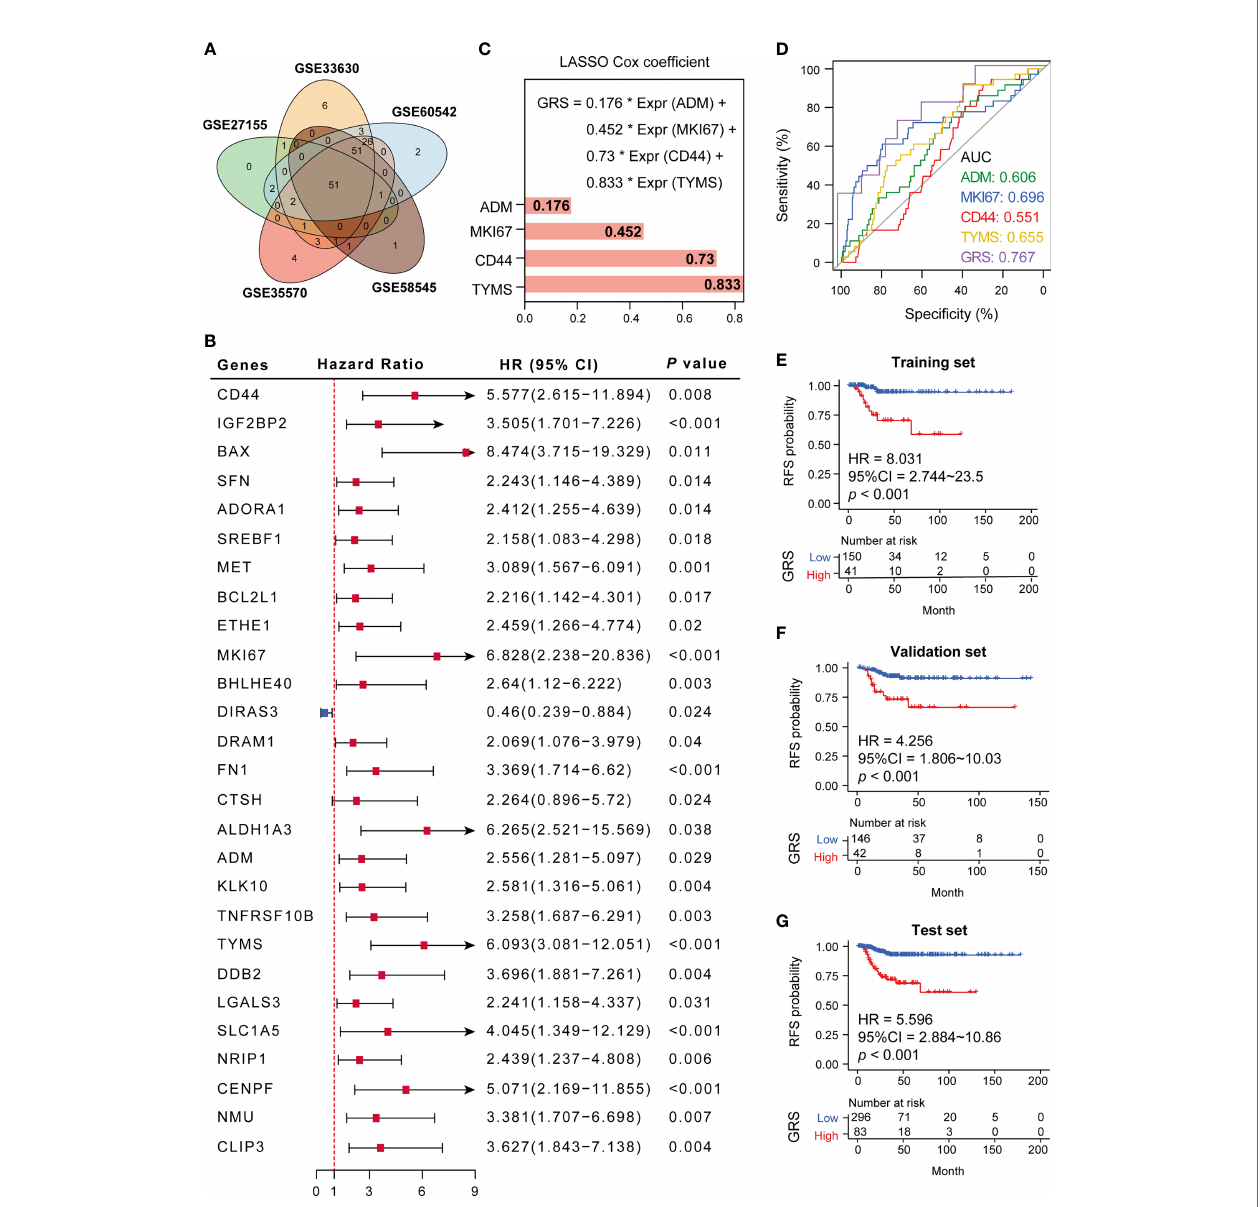
FIGURE 3 | Establishment of a glycolysis-related gene signature. (A) Fifty-one GRGs were co-differentially expressed in 5 GEO cohorts (GSE33630, GSE60542, GSE58545, GSE35570 and GSE27155). (B) Twenty-seven differential glycolytic genes have prognostic value. (C) The Cox algorithm was used to construct a 4-gene glycolytic risk score (GRS). (D) ROC curve for DTC recurrence by glycolysis-related genes between patients with or without recurrence in the combined or respective GRG. (E – G) Kaplan – Meier curves of 4 glycolysis-related genes in the training, validation and test sets. *p <